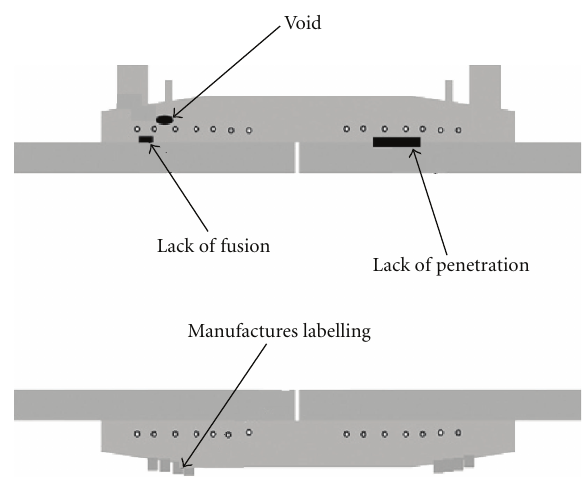
Figure 2: General structure and location of joint